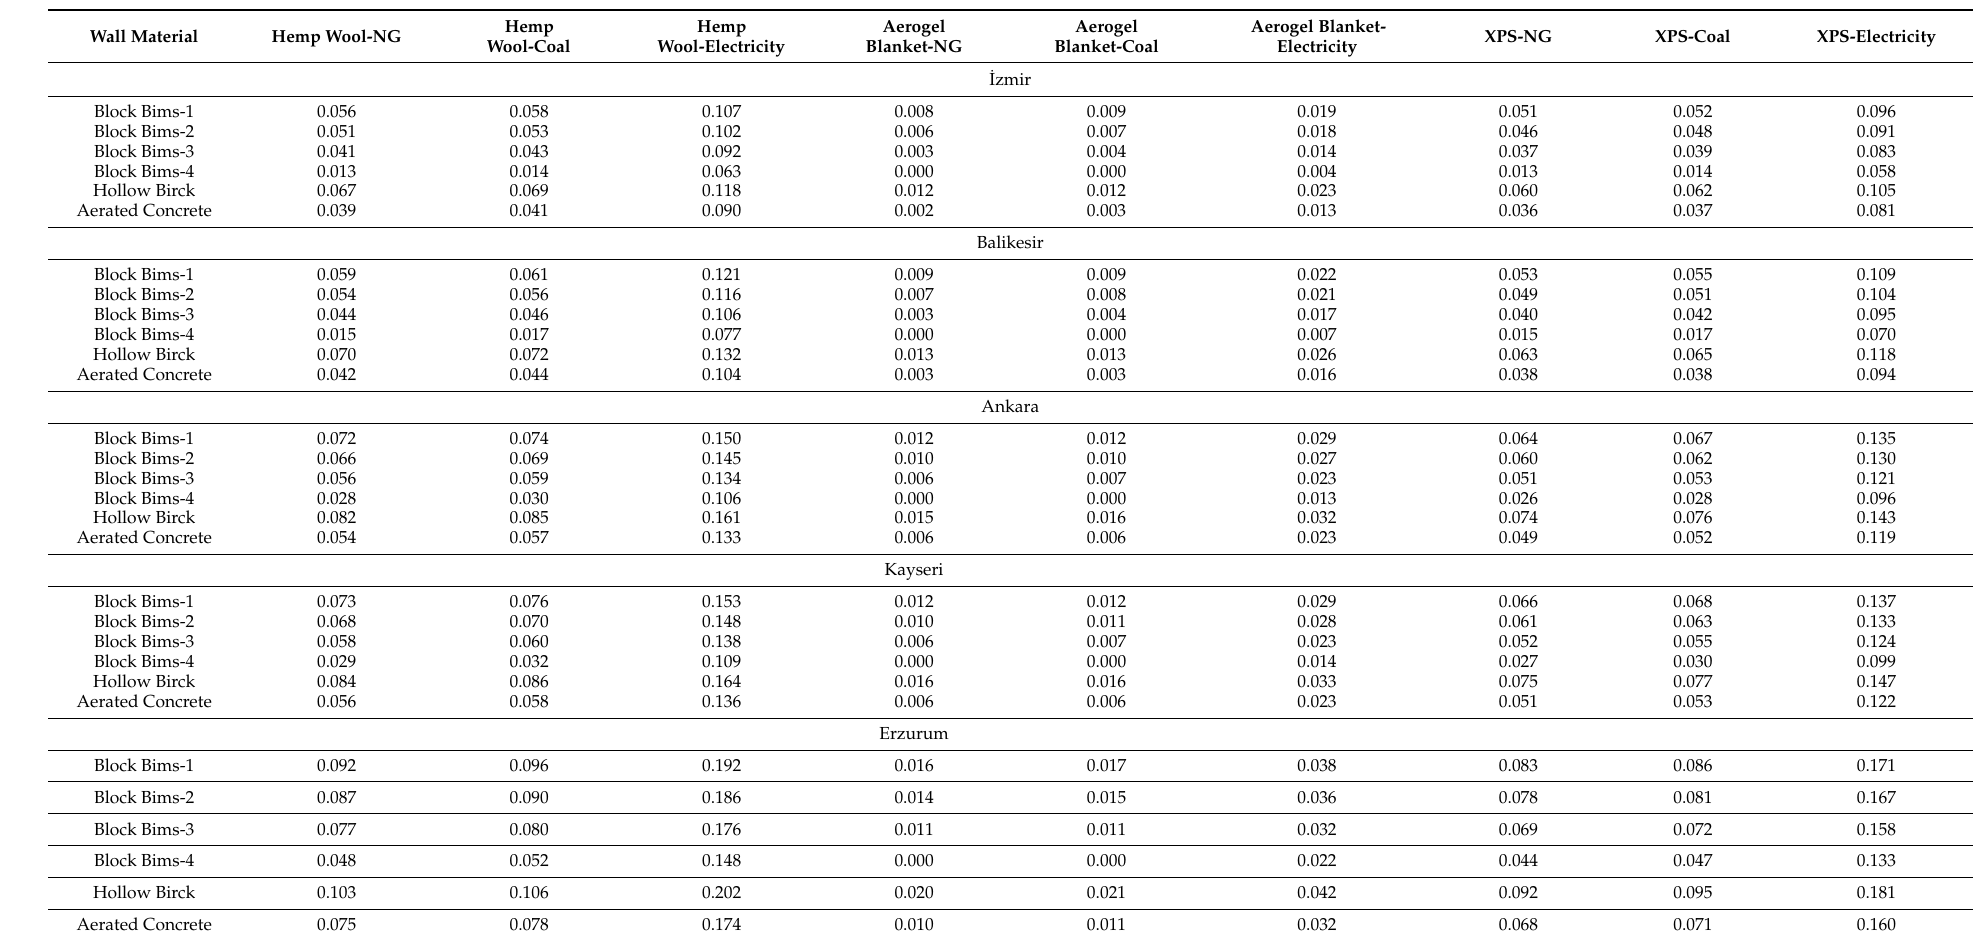
Table 6. The optimum insulation thicknesses for selected